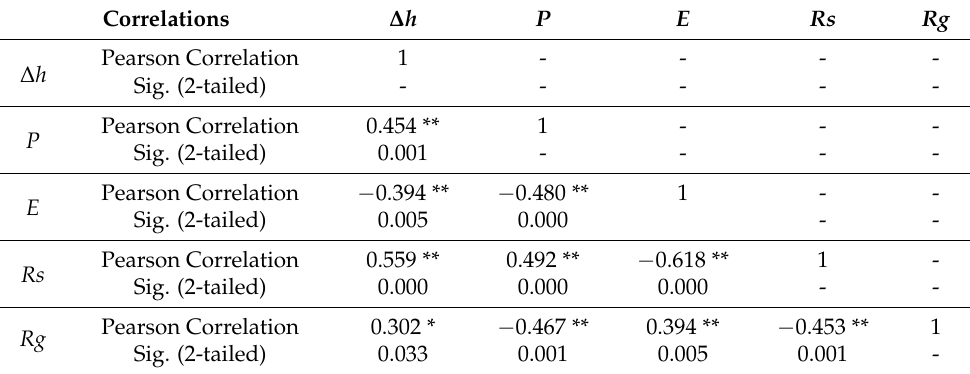
Table 7. Pearson correlation coefficients between ∆ h , P , E , Rs and Rg